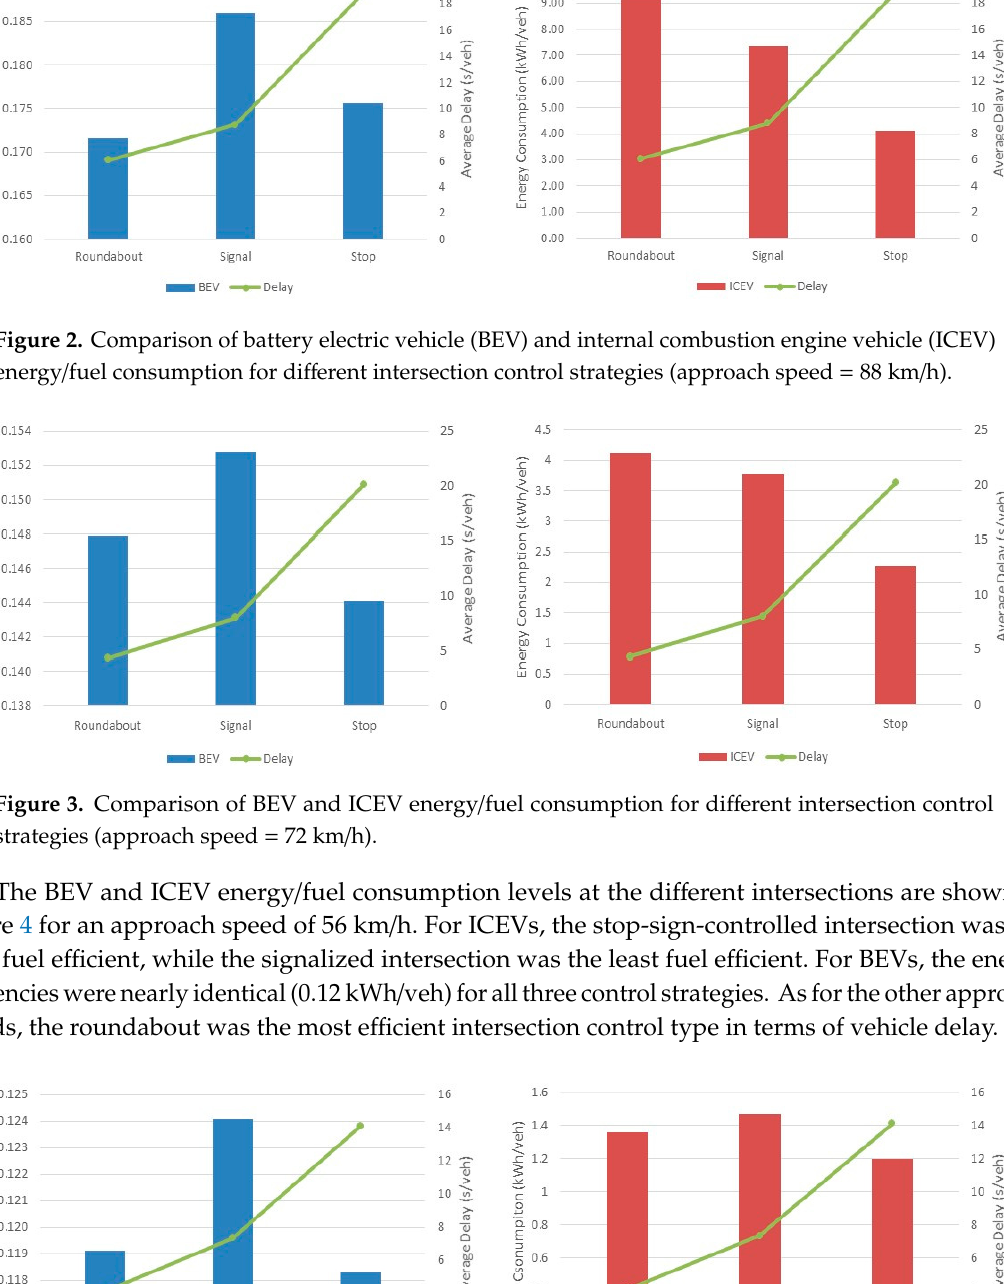
Figure 2. Comparison of battery electric vehicle (BEV) and internal combustion engine vehicle (ICEV) energy/fuel consumption for different intersection control strategies (approach speed = 88 km/h).